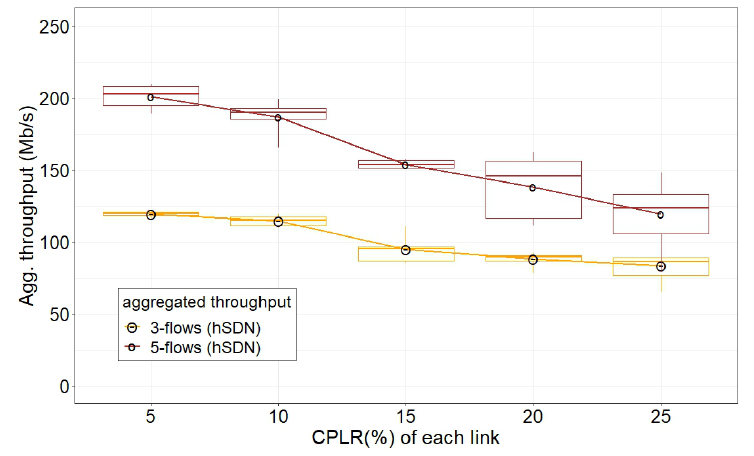
Figure 16. Data plane performance (aggregated throughput) of hSDN during data plane link failures for various times under unreliable control plane conditions in a 9-node grid